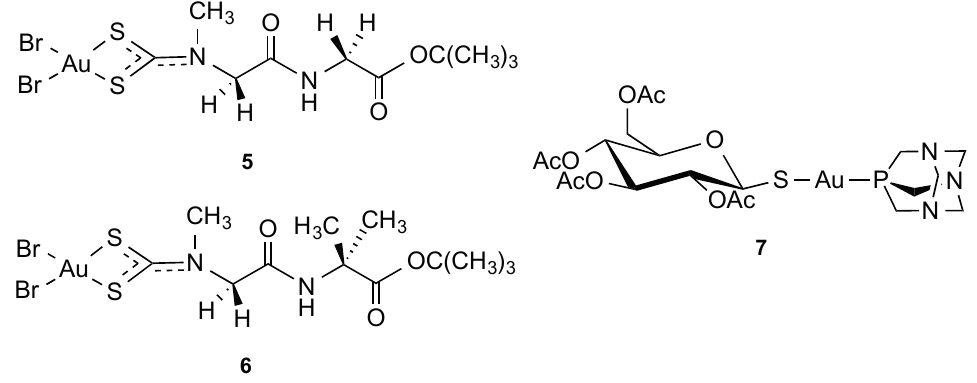
Figure 8. Au(III) dipeptidedithiocarbamato and Au(I)-thiosugar